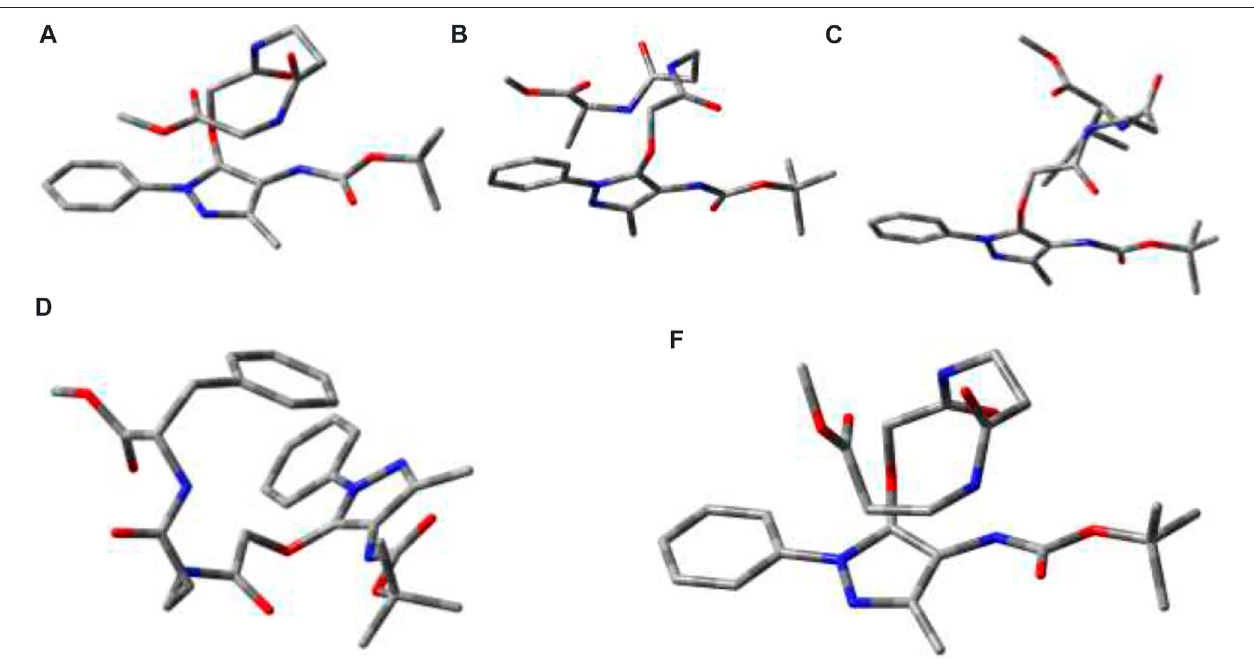
FIGURE 8 | Energy-minimized conformer without hydrogen atoms. 2a ( E = 31.2 kcal/mol; GBSA steric energy = 18.6 kca/mol; dielectric constant: 1; dipole moment: 4.2); 2b ( E = 34.7 kcal/mol; GBSA steric energy = 22.3 kca/mol; dielectric constant: 1; dipole moment: 4.2); 2c ( E = 38.8 kcal/mol; GBSA steric energy = 25.8 kcal/mol;dielectricconstant:1;dipolemoment:5.0);and 2d ( E =56.0 kcal/mol;GBSAstericenergy=41.4 kcal/mol;dielectricconstant:1;dipolemoment:6.0); 2e ( E = − 3.0 kca/mol; GBSA steric energy = − 15.6 kca/mol; dielectric constant: 1; dipole moment: